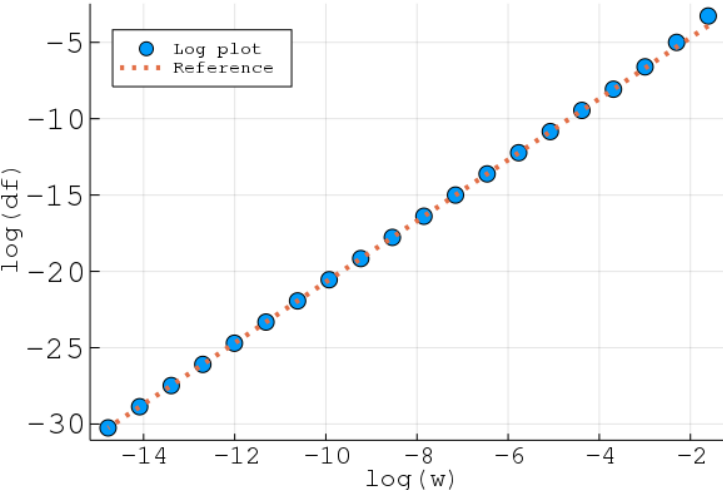
( f ( x ) − φ ( x )) vs. w : = 2 (cid:101) (circles) and a reference line X ( (cid:101) ) x ∈ X ( (cid:101) )